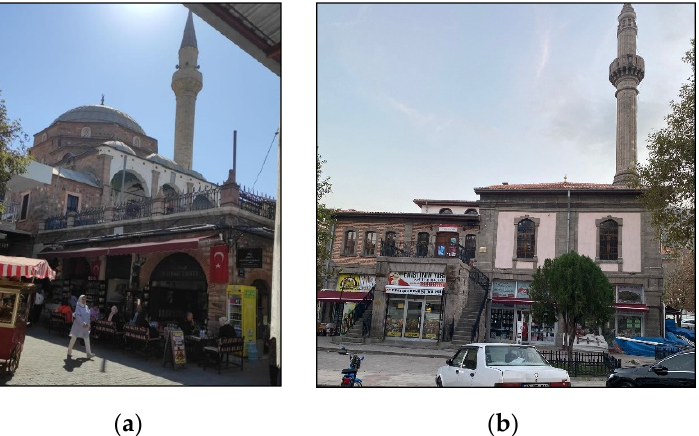
Figure 1. ( a ) Isparta Firdevs Bey Mosque and its covered bazaar (bedesten); the mosque and commercial unit are located close to each other ( b ) Tokat Takyeciler Mosque and its covered bazaar; the mosque and commercial unit are located adjacent to each other.